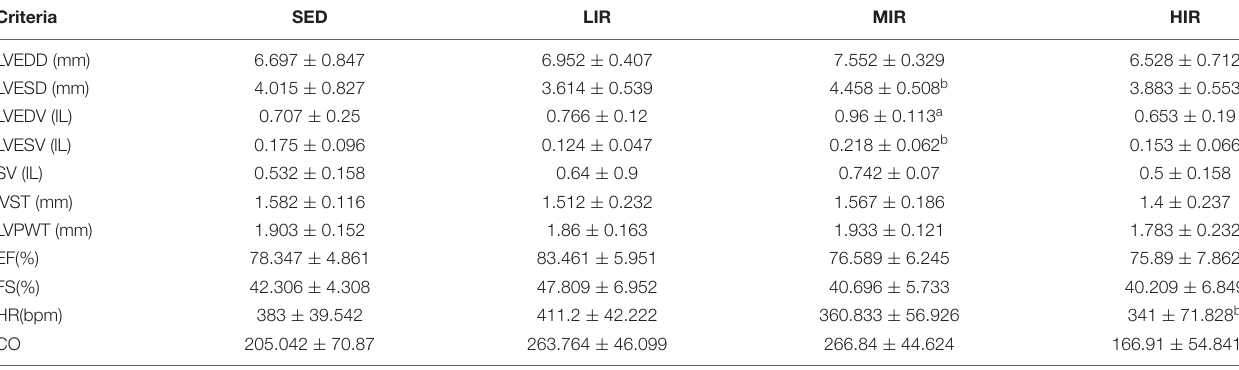
Data are presented as the means ± SEM. a P < 0.05 vs. SED.